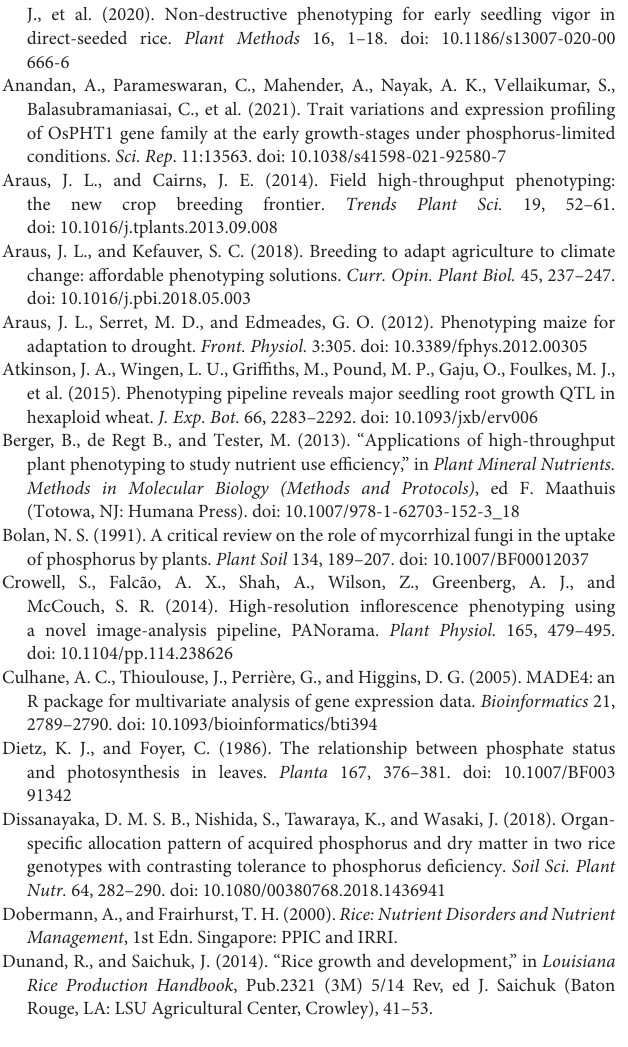
Supplementary Figure 4 | Hierarchical clustering and heat map of the 18 genotypes and 38 morpho-physiological and geometric traits. Each column represents a genotype, and each row represents a trait. The horizontal bar represents the treatment difference. Deficient (D) represented by pink colour, and Control (C) is represented by grey colour. The genotypes are grouped into two major clusters, and those having better shoot growth under deficient conditions and control are separated from the other genotypes. Supplementary Table 1 | List of genotypes used in this study. Supplementary Table 5 | Stress tolerance indices and significant traits measured under P deficient and control